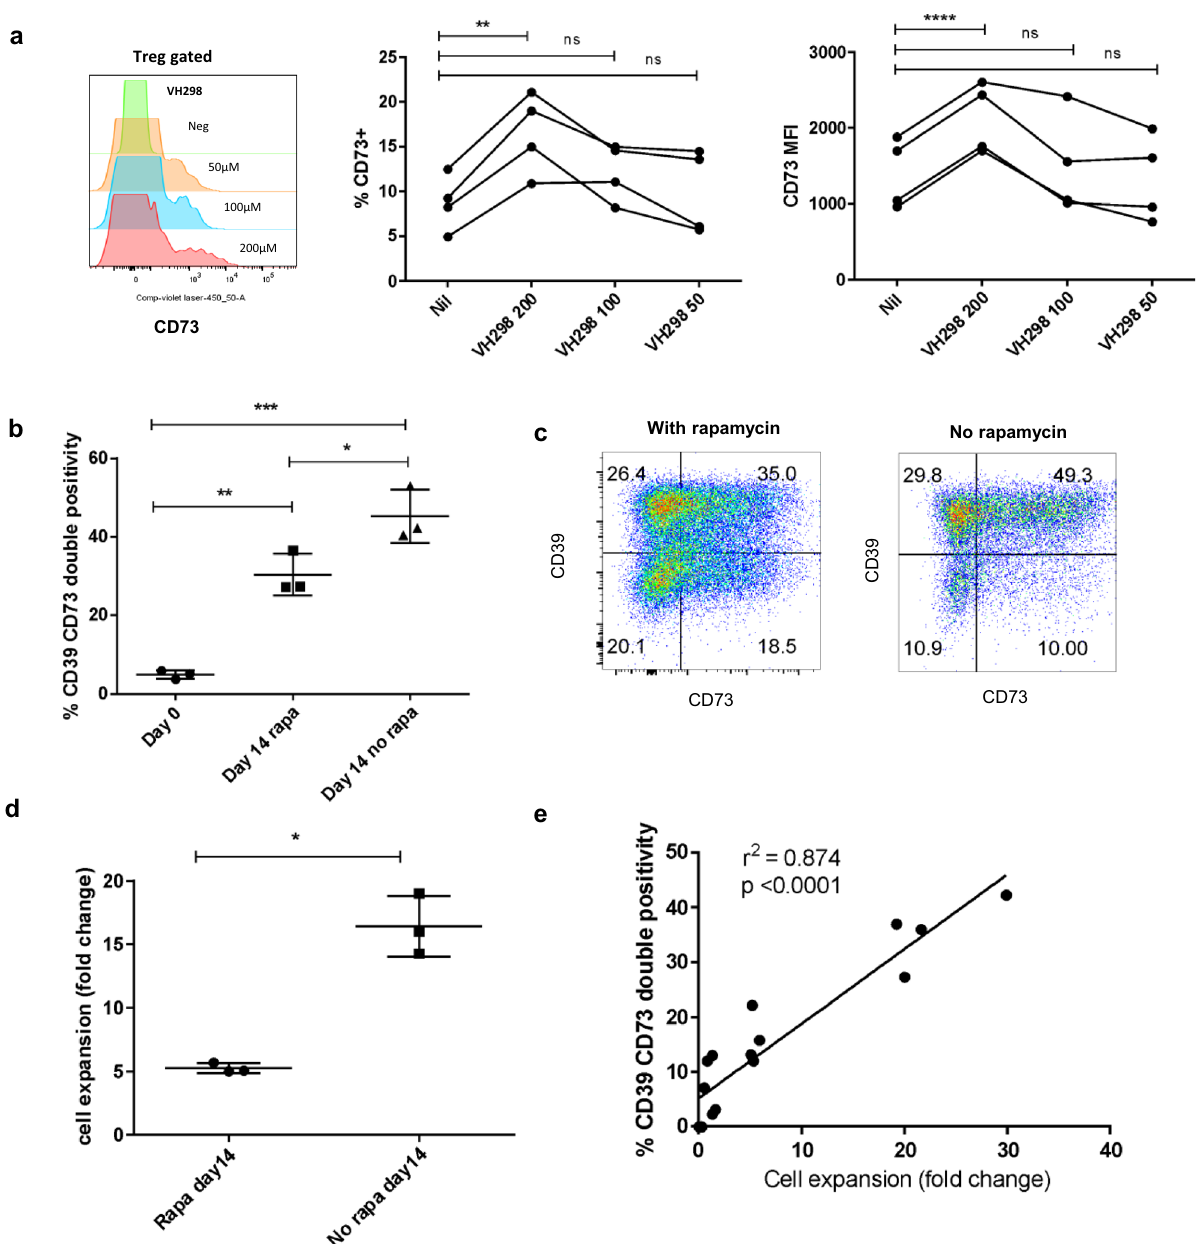
Fig. 5 CD73 upregulation in human Tregs can be achieved by stabilization of HIF1A, and is gained more rapidly in the absence of rapamycin. a Percentage of CD73 + cells and MFI (geometric mean fl uorescent intensity) of CD73 on ex vivo CD3 + CD4 + CD25 hi CD127 lo Tregs from 4 donors as measured by fl ow cytometry following 30 h of culture with and without VH298 at 200, 100 and 50 μ M. Increased CD73 was observed between the 200 μ M concentration and untreated cells both for % CD73 and MFI. Example histogram from one donor shown on left. (One-way ANOVA with Dunnett ’ s correction). b Percentage CD39 + CD73 + co-expression in expTregs cultured in the presence and absence of rapamycin after one round of expansion (three donors, one-way ANOVA followed by Tukey ’ s multiple comparison testing). c Representative example of CD39/CD73 co-expression in expTregs cultured with and without rapamycin. d Rate of expansion (fold change) in expTregs cultured with and without rapamycin (three donors, two-tailed paired t -test). e Rate of expansion vs gain of CD39/CD73 co-expression in expTregs (Pearson ’ s rank r = 0.875). * P < 0.05, ** P < 0.01, *** P < 0.001, **** P <